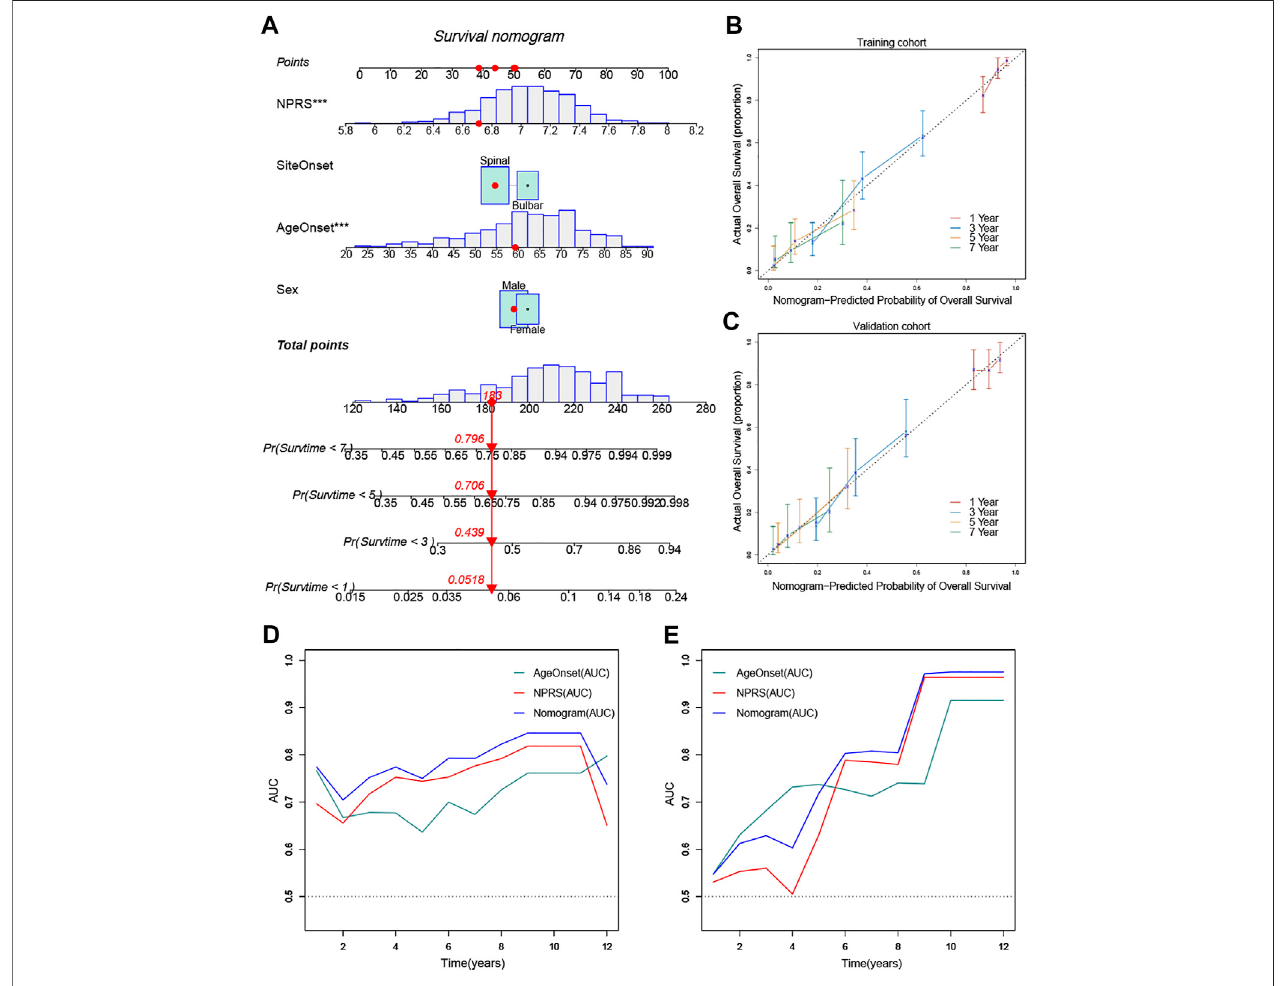
FIGURE 8 | Construction and validation of a predictive nomogram (A) The nomogram for predicting the overall survival of patients with ALS at 1, 3, 5, and 7 years (B) and (C) The nomogram showed high accuracy in the calibration analysis (D) and (E) The nomogram exhibited the most powerful capacity for survival prediction compared with other clinicopathological features in both training and validation cohorts. *** p < 0.001.